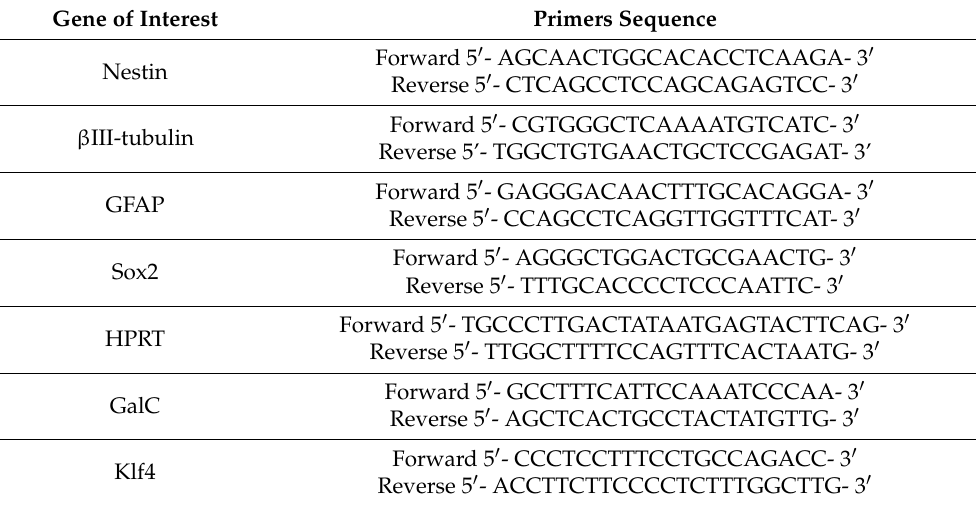
Table 2. Primers (5 (cid:48) -3 (cid:48) ) used for real